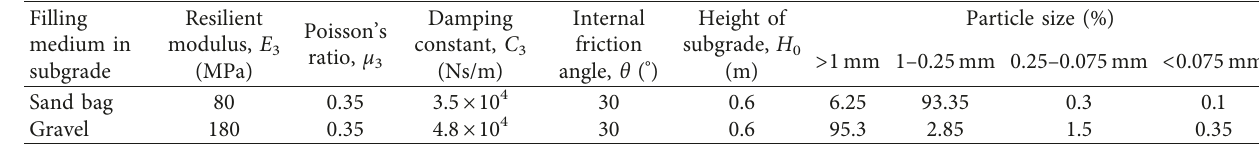
Table 1: Parameters of the subgrade.